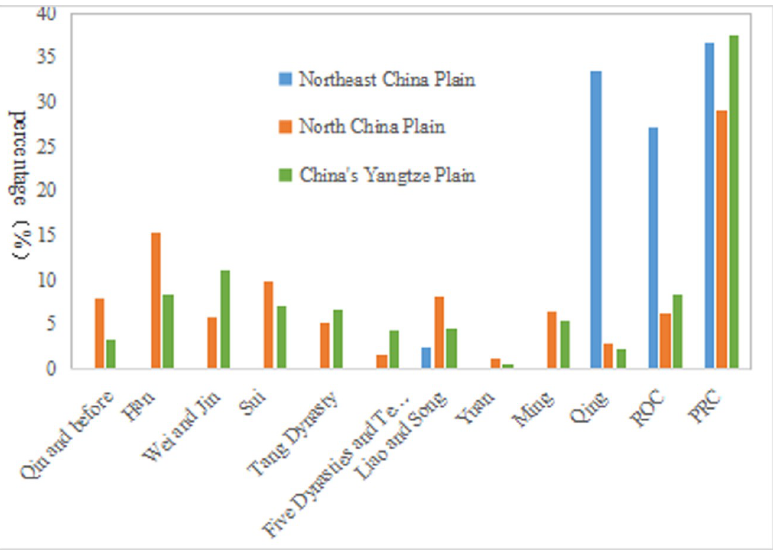
Fig 7. Distribution characteristics of naming time of county-level administrative toponyms in